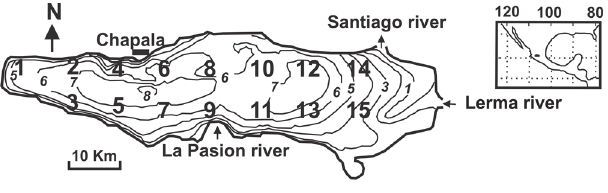
Fig. 1. Map of Lake Chapala, Mexico. Numbers in bold represent sample sites and numbers in italic lake